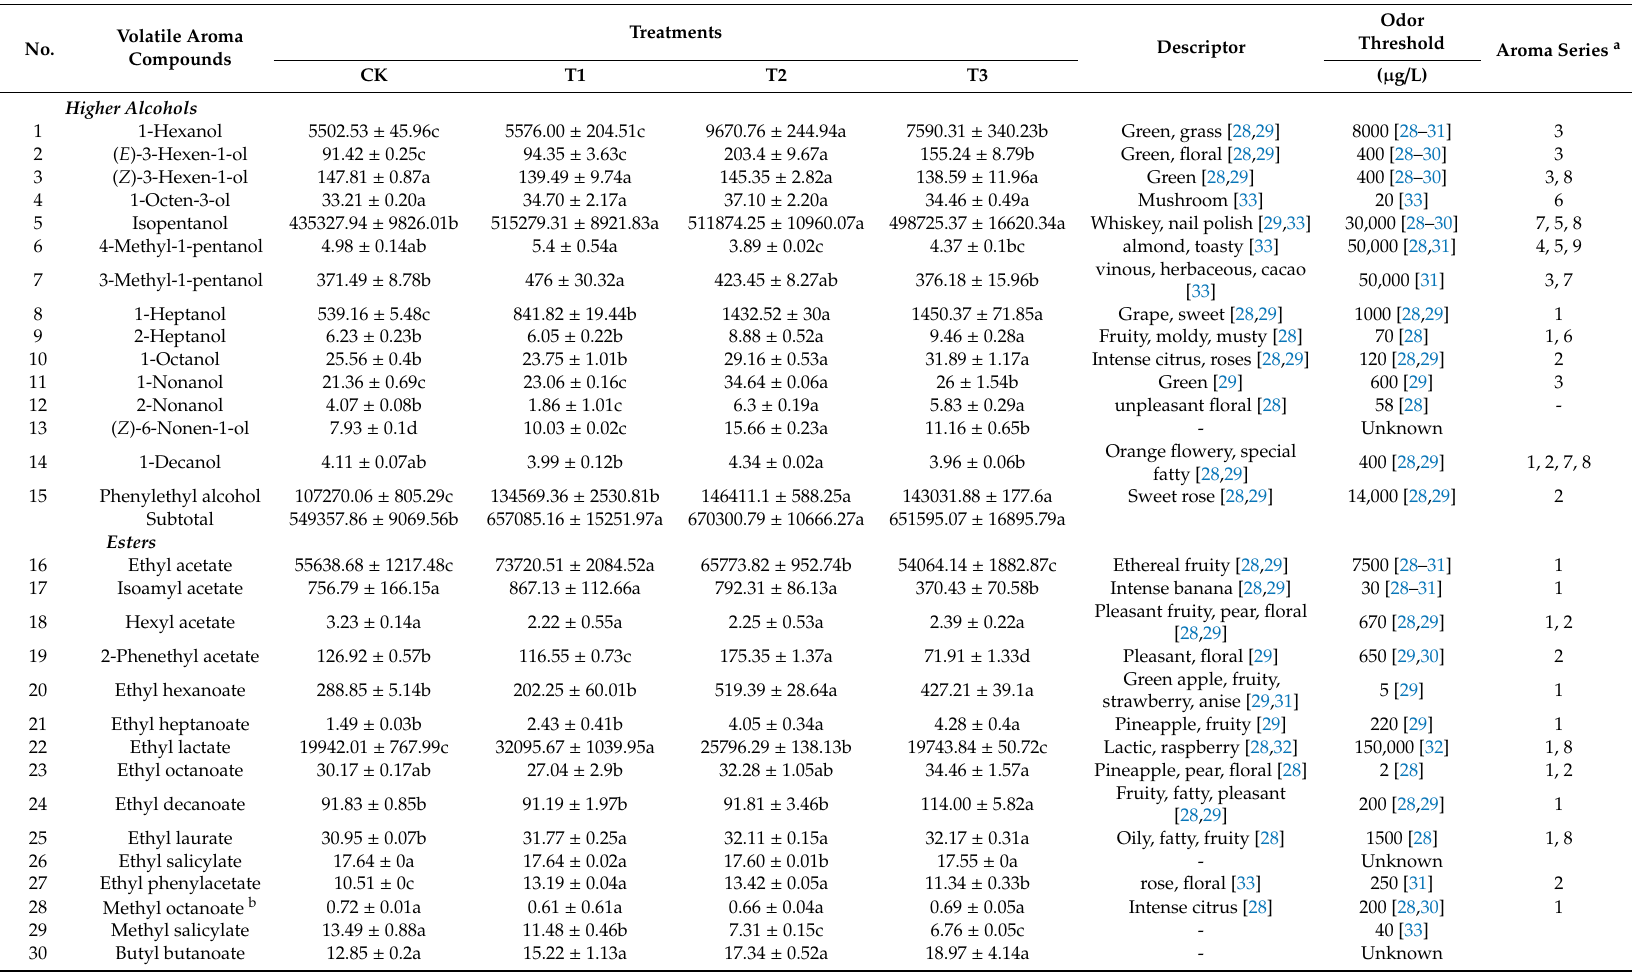
Table 3. Concentrations ( µ g / L, mean ± standard deviation) of free volatile compounds in Cabernet Sauvignon wines produced from control berries (CK) and sequential harvest berries (T1, T2, and